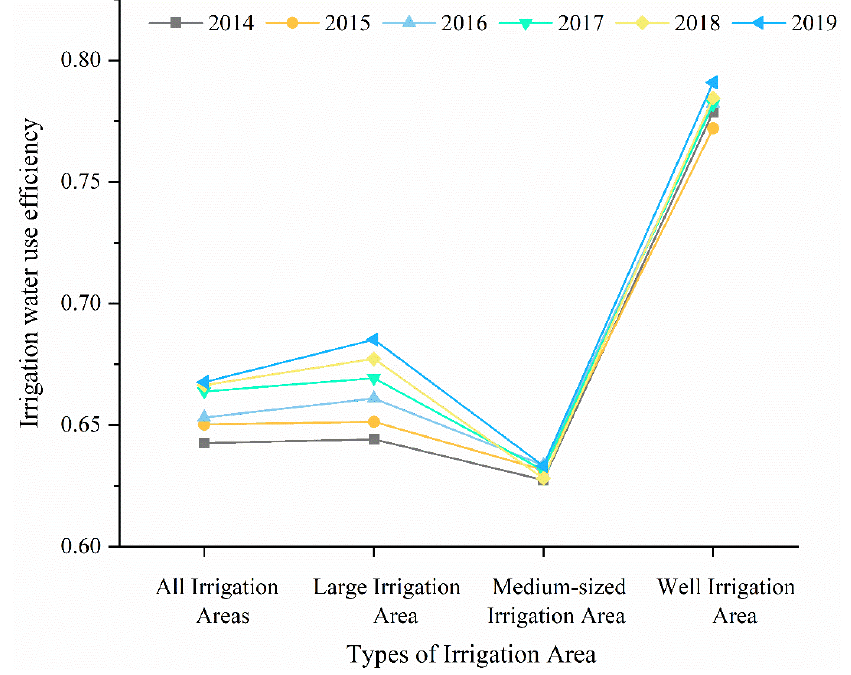
Figure 9. Effective utilization coefficient of irrigation water in various types of irrigation areas from 2014 to 2019. 2014 to